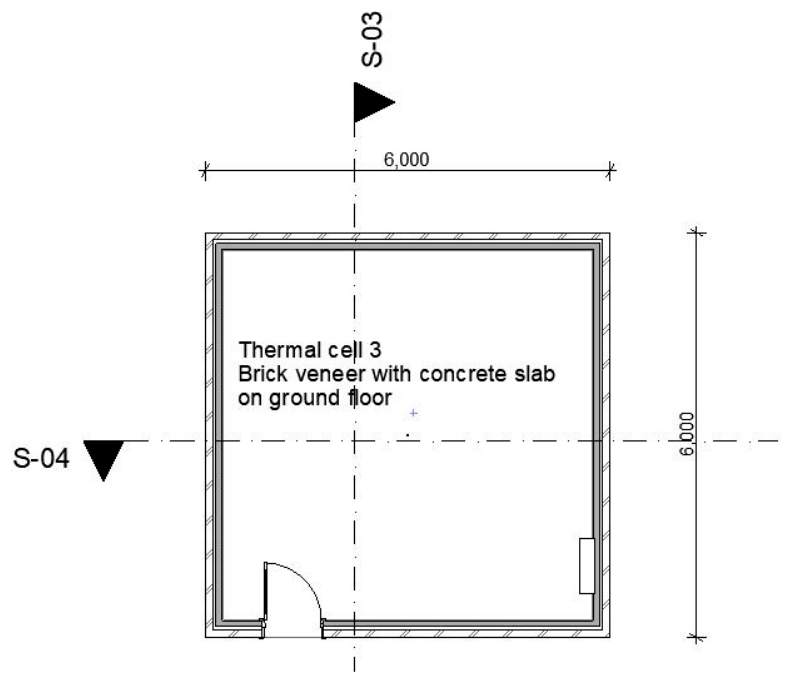
Figure 4. Floor plan of test building.